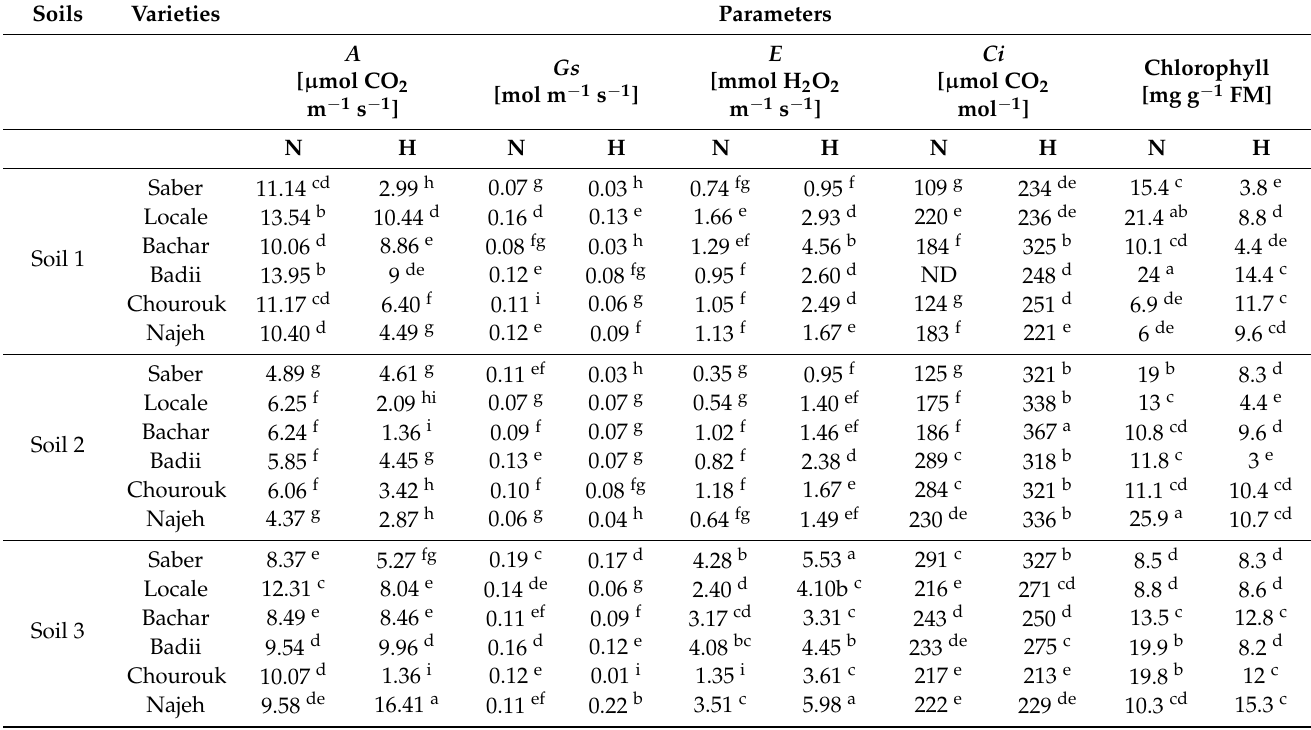
Table 3. Net assimilation rate of CO 2 ( A ), transpiration ( E ), stomatal conductance ( gs ) and